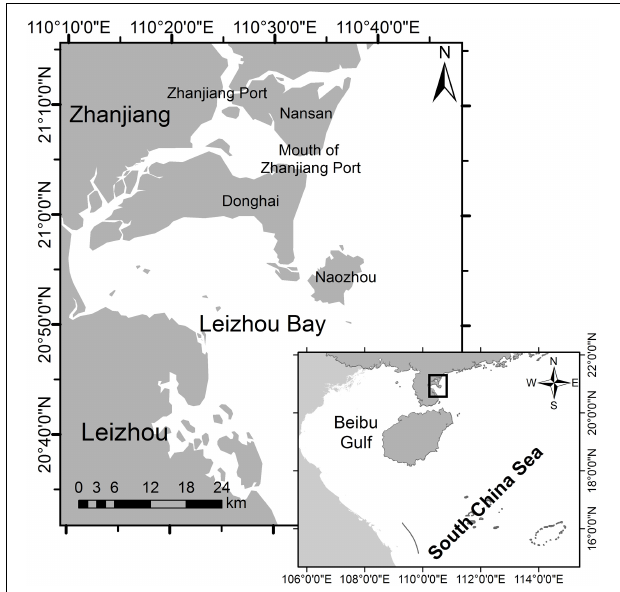
FIGURE 1 | Map of the study area: the eastern waters of Zhanjiang,